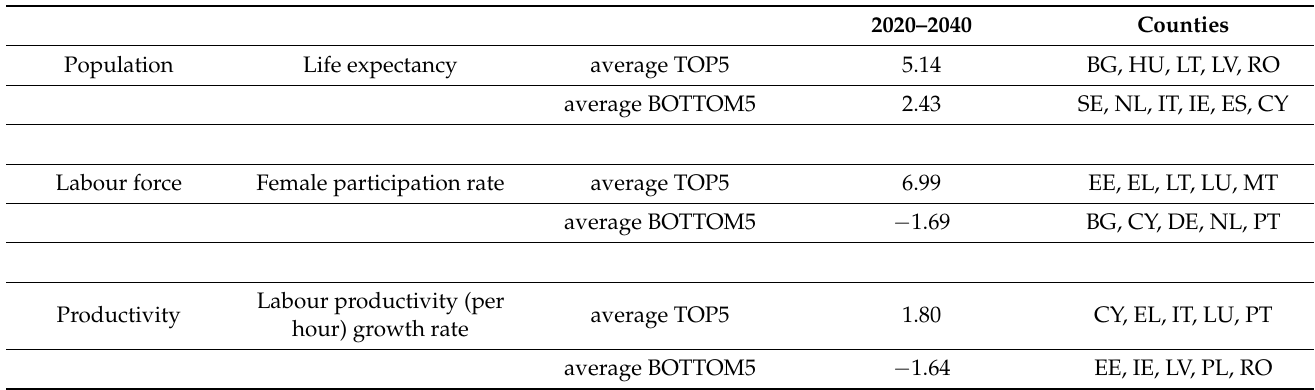
Table 2. EU variability in key projection drivers: top and bottom